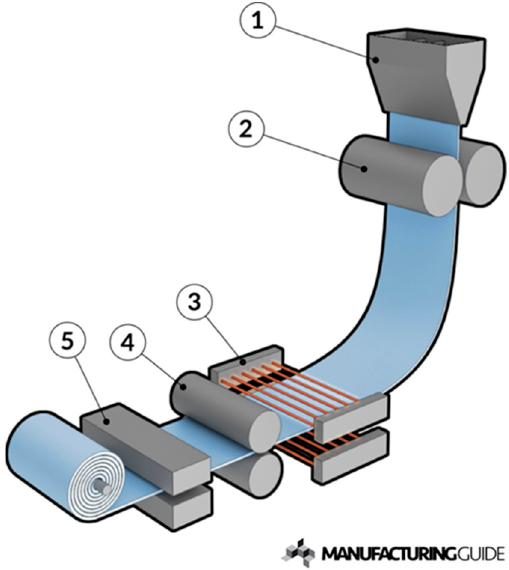
Figure 1. Generic process layout for direct powder rolling. Powder feeder (1), roller (2), sintering furnace (3), additional rolling (4), and cooling (5) (source: https://www.manufacturingguide.com/en/metal-powder-rolling).